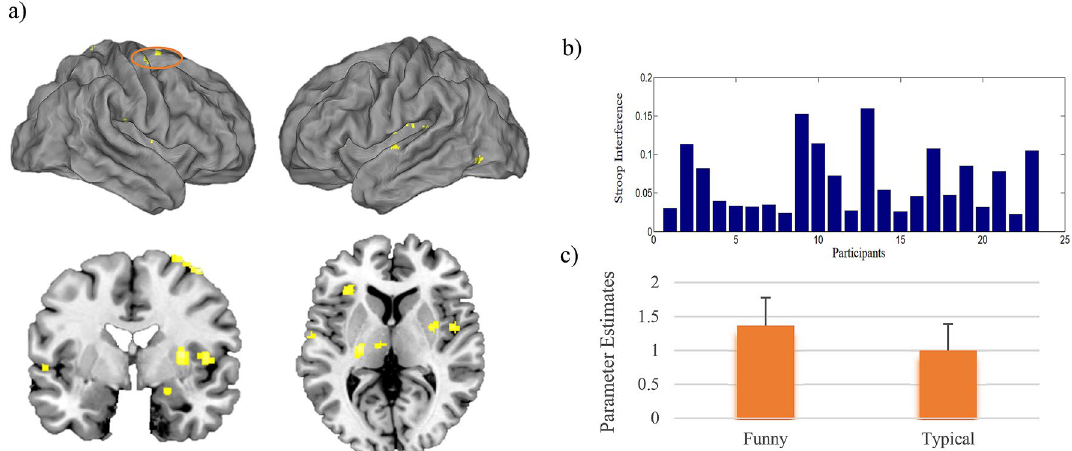
Figure 2. Functional activity: covariate analysis (stroop interference): ( a ) the functional covariation analysis of the stroop interference in the FUN > TYP contrast revealed a positive relationship between individual differences in cognitive inhibition and activation in several brain regions associated with humorous processing (t values are plotted). ( b ) Distribution of the stroop interference values per participant. The value represents the difference between reaction times in the congruent vs. incongruent word-color pairs condition. ( c ) Functional activity of the superior/medial frontal gyrus, the cluster was used for the subsequent connectivity analysis. Error bars represent